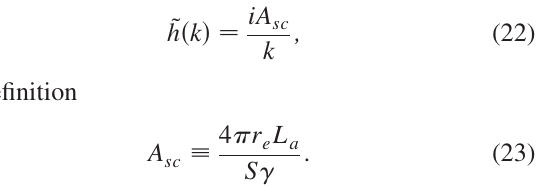
(see Appendix B). The 0